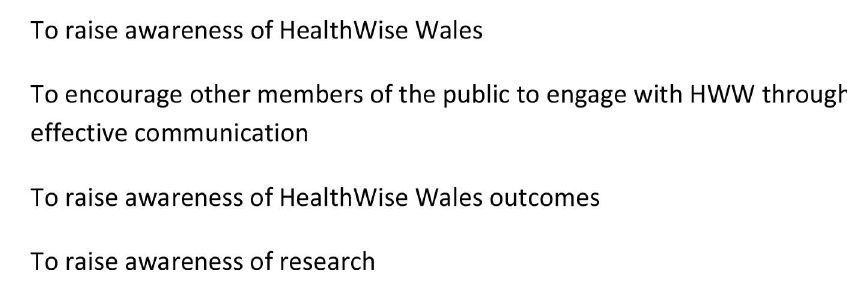
Figure 2: Role of Champions and